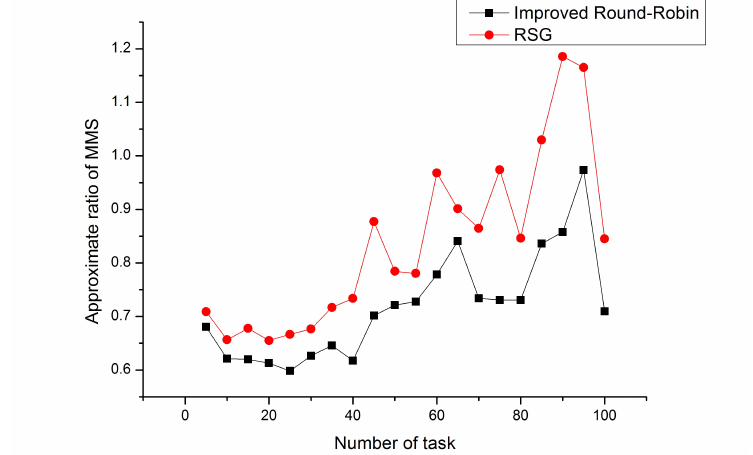
Figure 2. Improved Round-Robin vs. RSG.